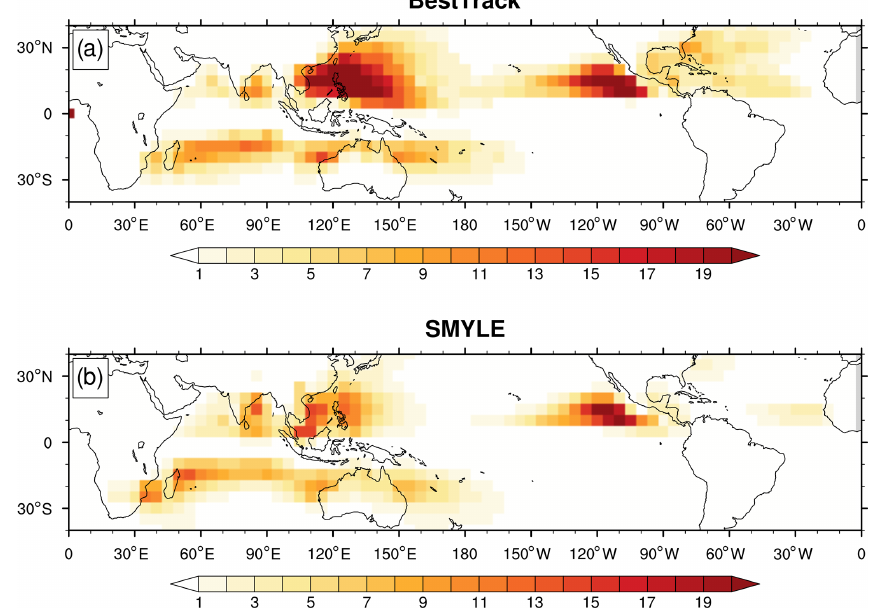
Figure B8. Annual mean global TC track density (over 5 ◦ × 5 ◦ box) during 1970–2018 in (a) observations and (b) SMYLE lead month 1 forecasts (averaged over four initialization